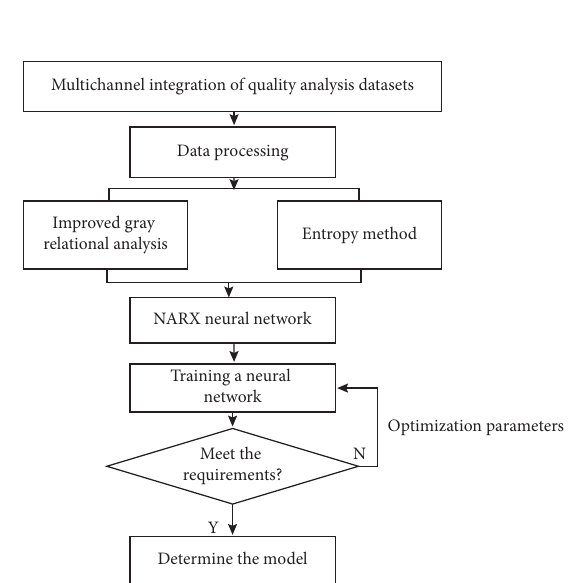
Figure 2: Flowchart of NARX neural network model setting.